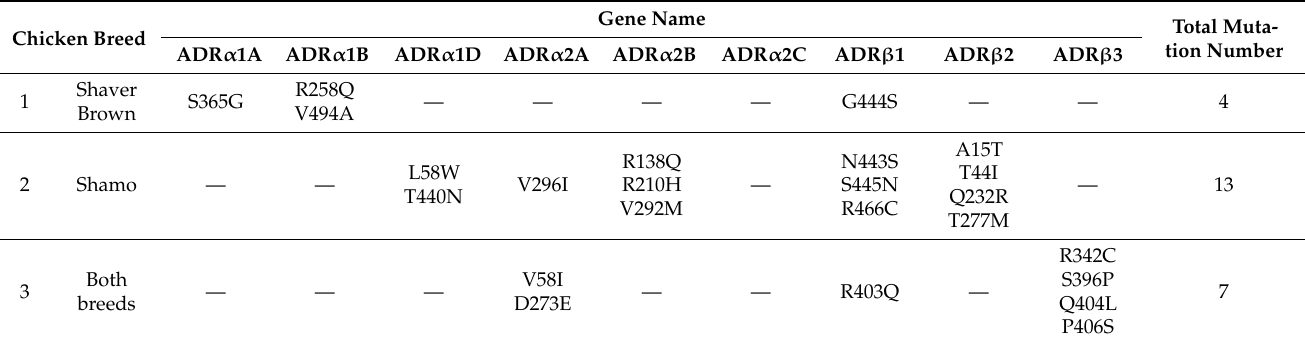
Table 2. The 24 amino acid mutation sites in the nine adrenergic receptor (ADR) genes in Shamo and Shaver Brown chickens.